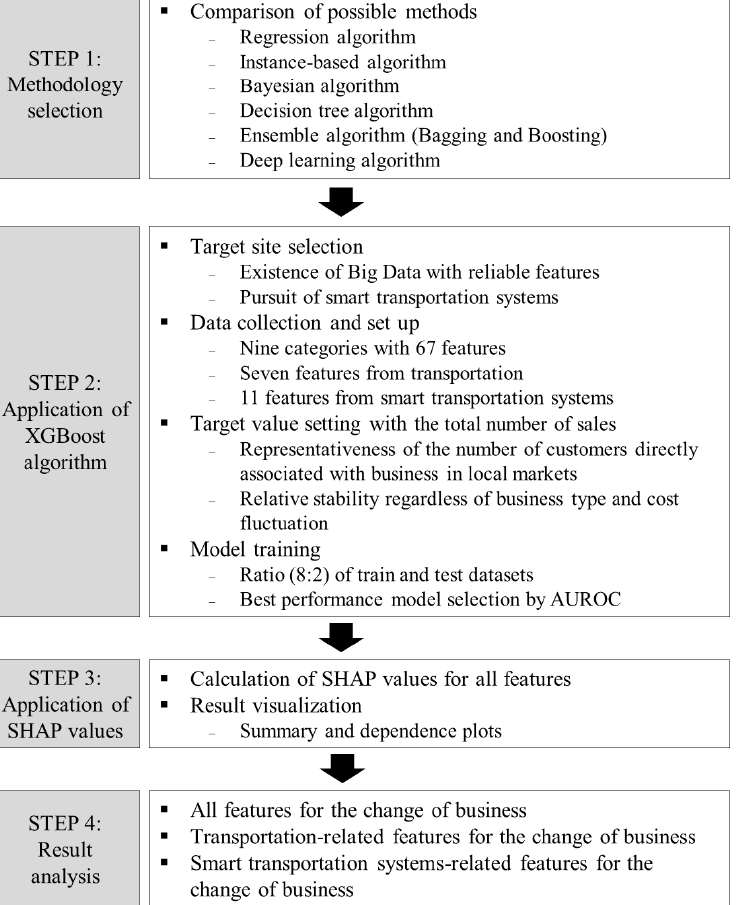
Table 3. Possible methods for analysis.